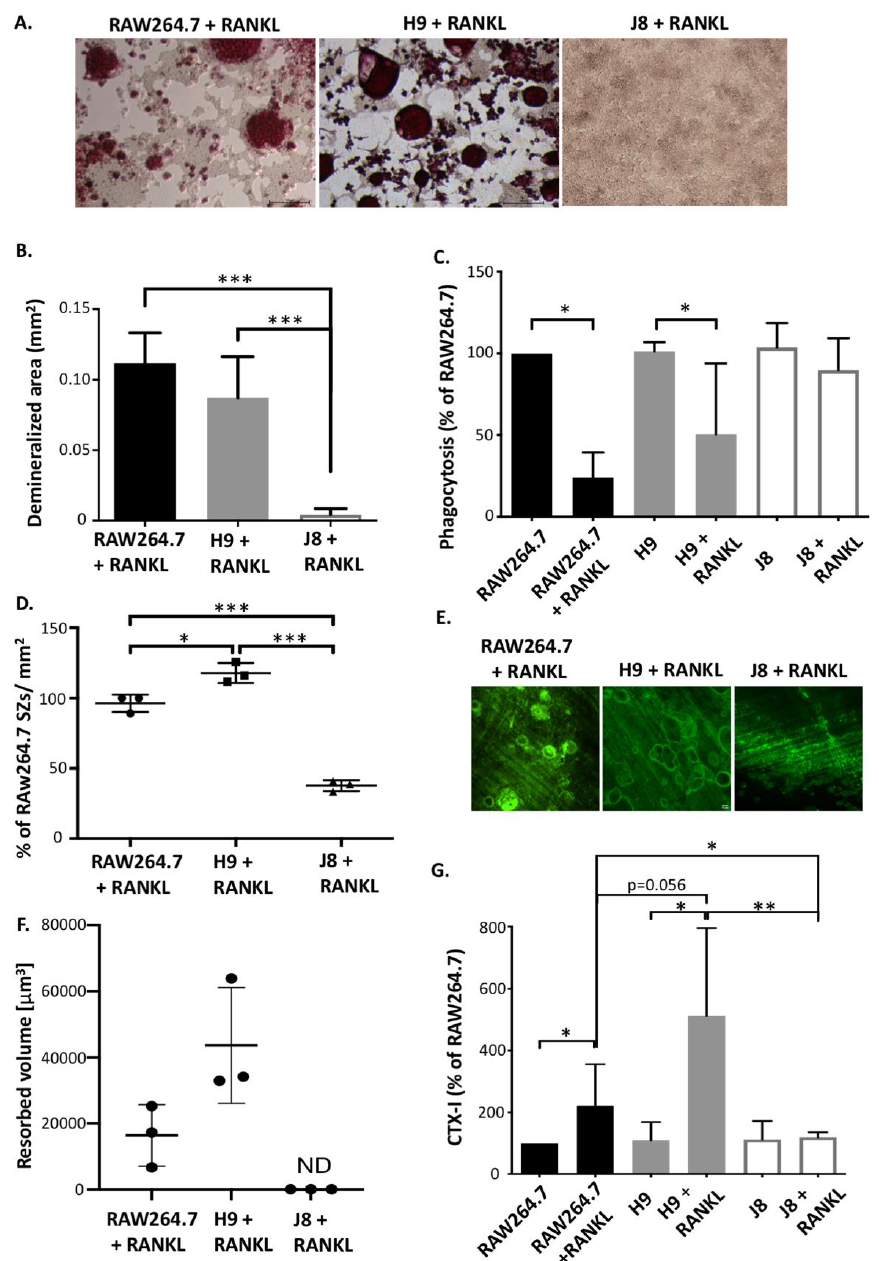
Figure 2. Osteoclast characteristics in RAW264.7 and sub-clones H9 and J8 in response to RANKL stimulation. ( A ) TRAP activity staining on the surface of hydroxyapatite wells showing area that had been acidified after 8 days. Scale bar 100 μm, all micrographs have the same magnification. ( B ) Quantification of the acidified area after 8 days (mean ± SD, n = 3). ( C ) Quantification of phagocytosis capacity after 5 days of differentiation with M-CSF or RANKL (mean ± SD, n = 4). Data were analyzed using Mann–Whitney U test. * = p value 0.05. ( D ) Quantification of sealing zones stained for f-actin on bone-coated coverslip on day 10. Quantification was done using ImageJ (mean ± SD, n = 3). ( E ) Quantification of the resorption pit volumes. n = 3. Scale bar 50 μm, all micrographs have the same magnification. ( F ) Bisphosphonate staining to identify resorption pits after 6 days of culture. ( G ) CTX-I measurement on Day 6. Statistical analysis with one-way ANOVA with Tukey’s multiple comparison * p < 0.05, ** p < 0.01, *** p < 0.001.